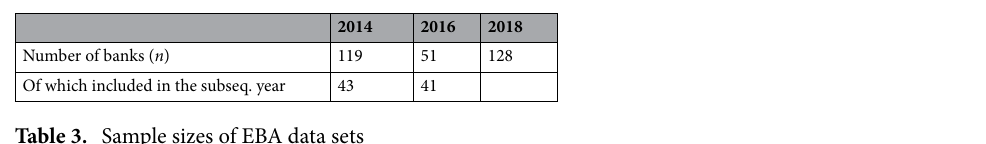
Table 3. Sample sizes of EBA data